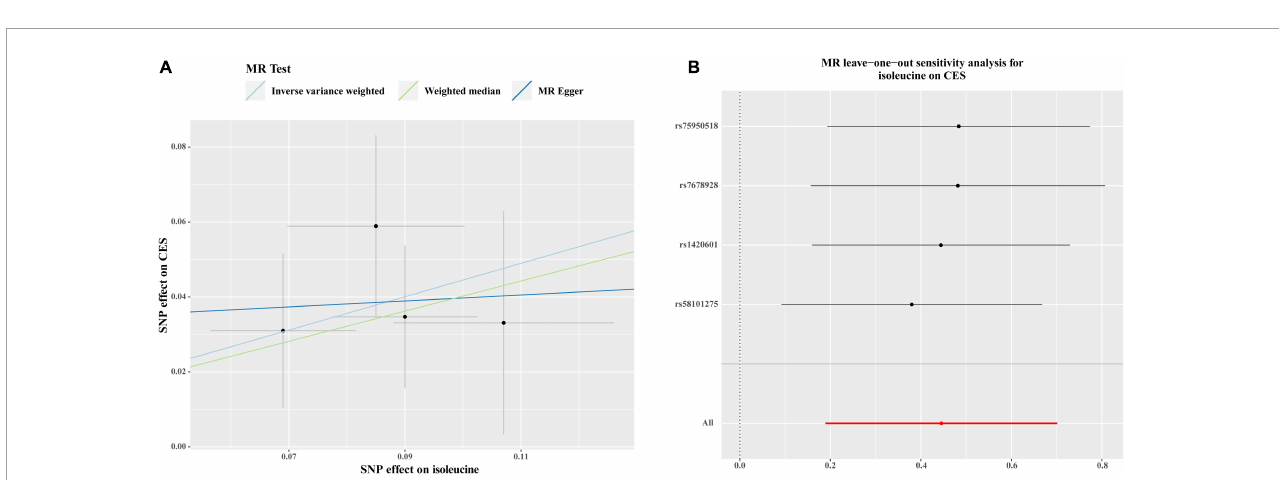
FIGURE3 Scatter plots (A) and MR leave-one-out sensitivity analysis (B) of genetic association with circulating levels of isoleucine against the genetic association with CES risk. (A) Each black dot indicates an SNP, plotted by the estimate of SNP on the isoleucine levels and the estimate of SNP on CES risk with standard error bars. The slope of the line represents the causal relationship, and each method has a different line. (B) Circles indicate MR estimates for isoleucine on CES using the IVW method if each SNP was omitted in turn. The bars indicate the confident interval. SNP, single nucleotide polymorphism; CES, cardioembolic stroke; MR, Mendelian randomization; IVW; inverse variance